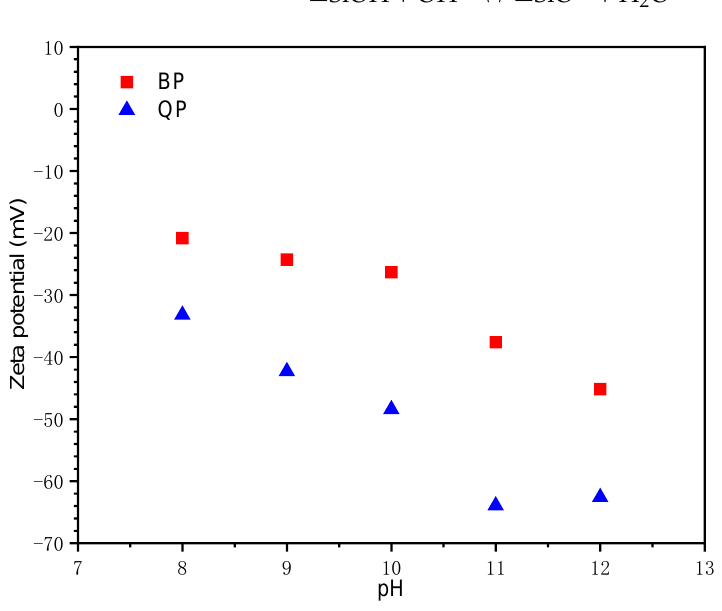
Figure 4. Zeta potential of BP and QP in NaOH solutions with pH from 8 to 12.